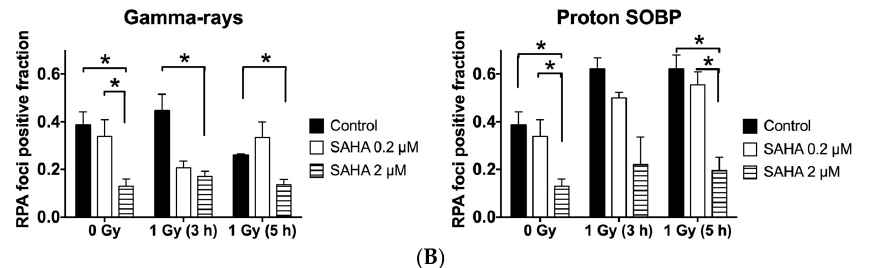
Figure 5. SAHA induced radiosensitization in homologous recombination repair. ( A ) Rad51 foci positive fraction in A549 cells; ( B ) RPA (Replication Protein A) foci positive fraction in A549 cells. Error bars indicate standard error of the means. All experiments were carried out at least three times independently. * marks indicate statistically significant differences ( p < 0.05).